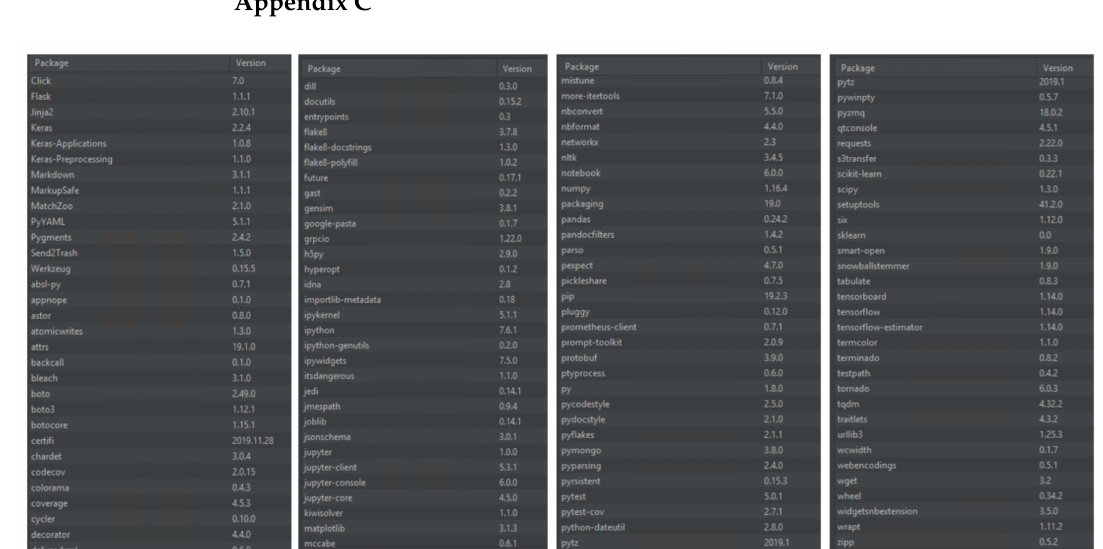
Figure A2. Python-based Keras libraries and prerequisites used for the experiment. The following is a depiction of the full packages and libraries being used for the purpose of setting up the python infrastructure to conduct the Siamese LSTM